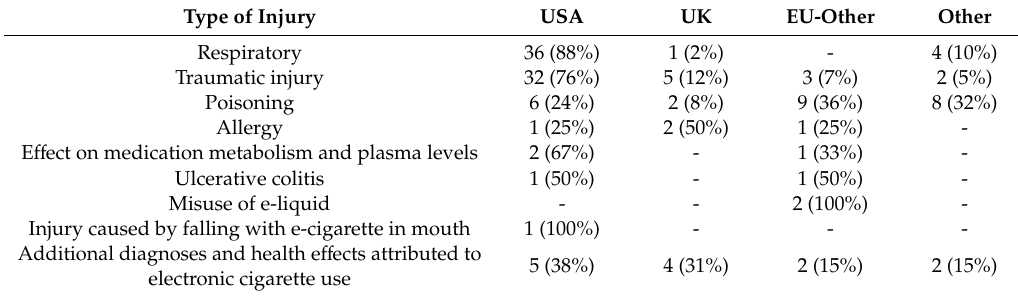
Table 1. Type of injury by geographical